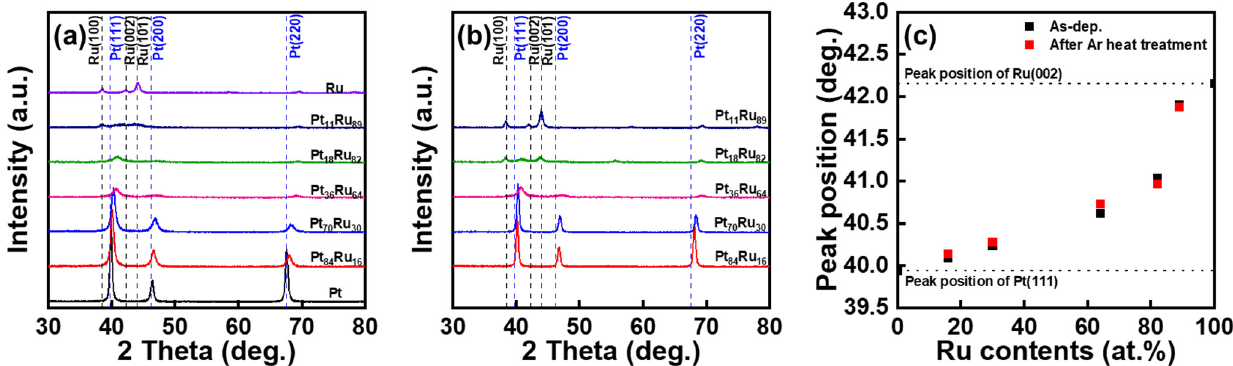
Figure 2. XRD patterns of PtRu bimetallic alloy thin films according to the film compositions ( a ) before, and ( b ) after Ar heat treatment at 700 °C under 1 Torr. ( c ) The peak positions of Pt (111) and Ru (002) before and after Ar heat treatment.